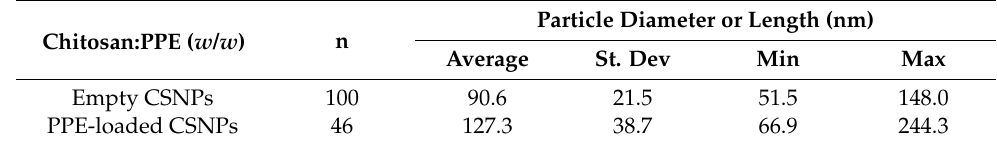
Table 4. Numerical values of particle size extracted from SEM images using ImageJ processing. Chitosan:PPE ( w/w )